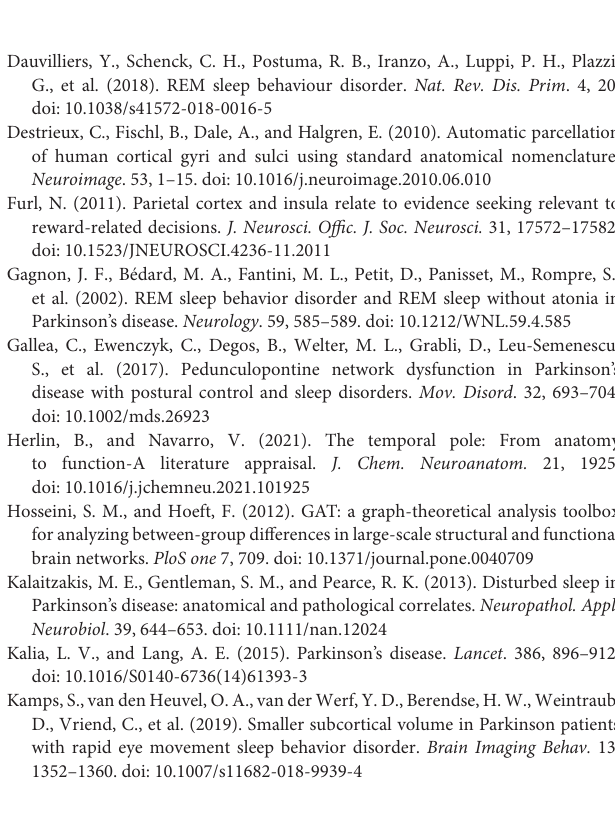
Supplementary Figure 1 | The distribution of brain regions with significant differences in nodal efficiency in HC, PD-npRBD, and PD-pRBD groups. The size of the node reflects the value of the nodal efficiency. Different colors indicate a functional classification of brain regions: red: primary, purple: association, blue: paralimbic, green -limbic; yellow: subcortical. The abbreviations of the 90 brain regions are given in Supplementary Materials (Online Resource). L, left hemisphere; R, right hemisphere. Covariate, age, sex, years of education and GDS; GDS, Geriatric Depression Scale. Supplementary Table 1 | Cortical and subcortical regions of interest defined in the